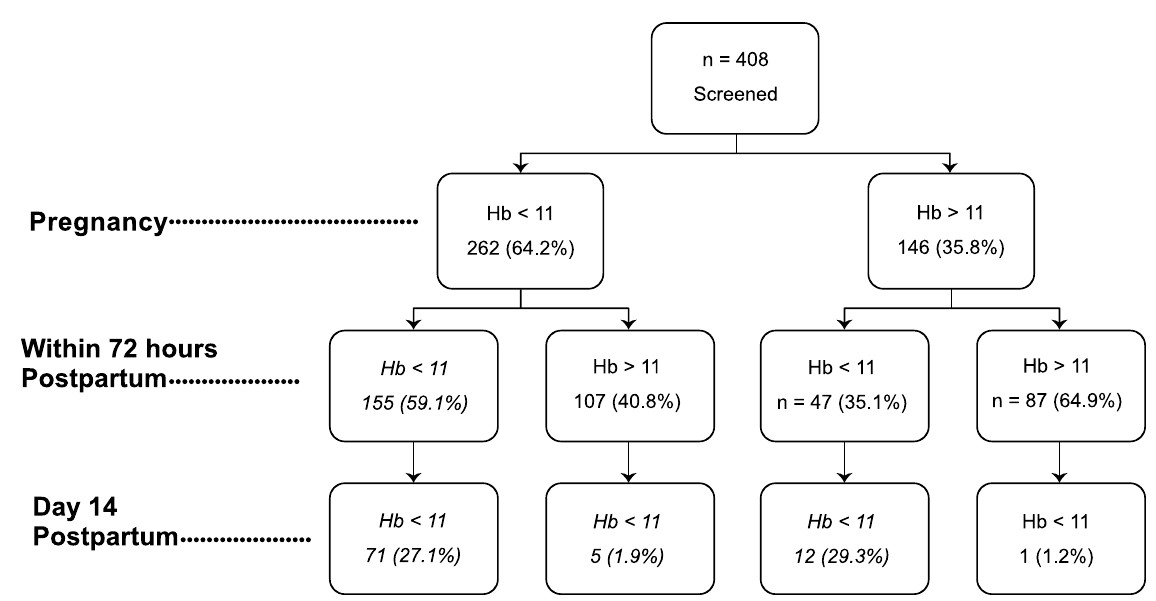
Figure 1. Prevalence, incidence and recovery of anaemia in pregnancy, within 72 hours postpartum and day 14 postdelivery.